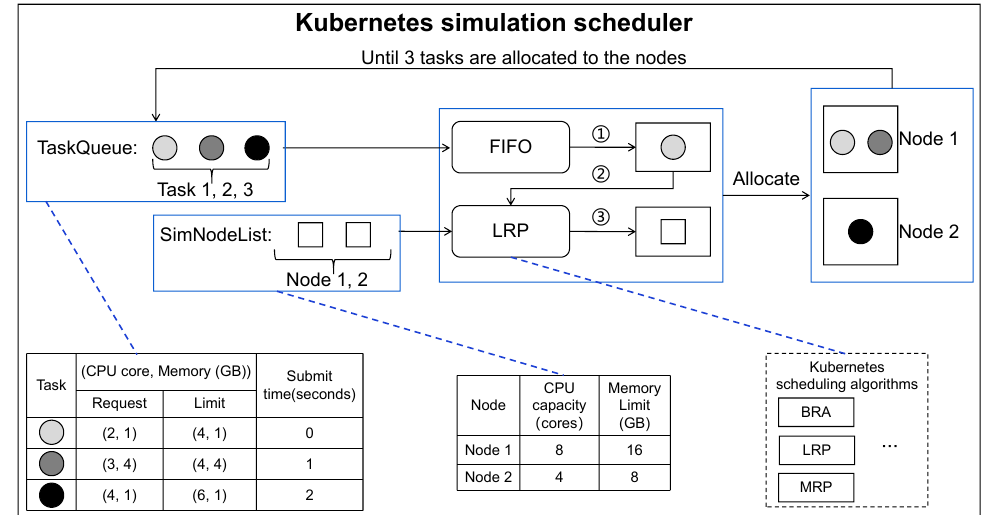
Figure 5. An example of TaskQueue scheduling using LRP in Kubernetes simulation